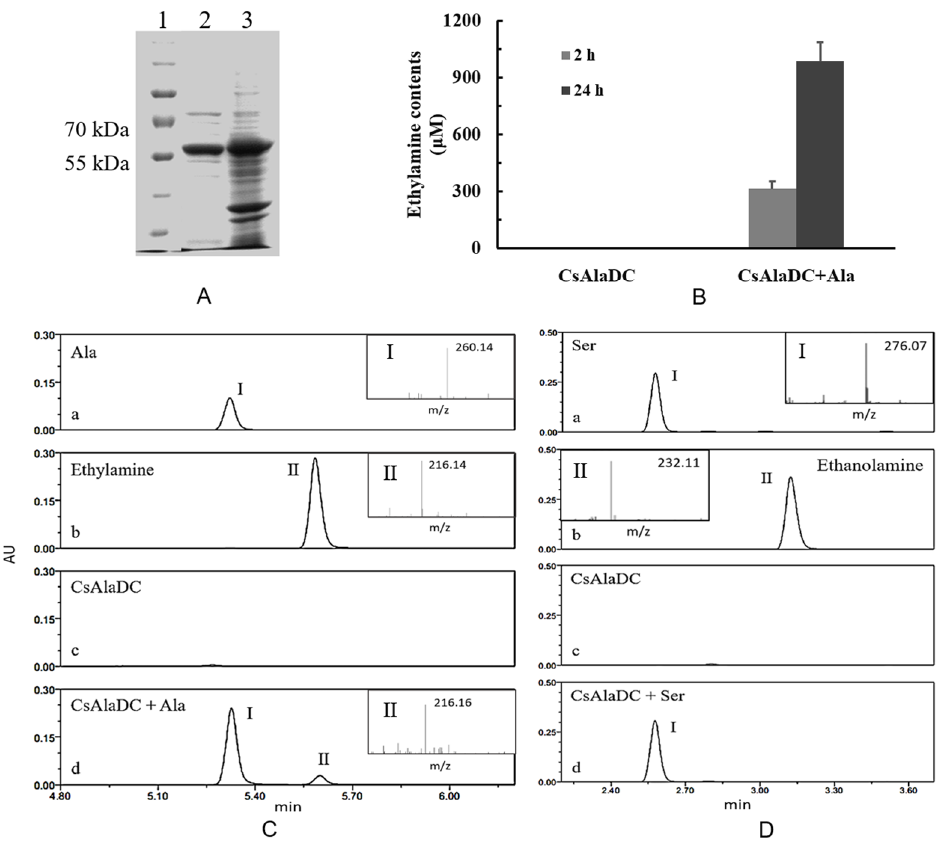
Figure 5. Expression, purification, and enzymatic activity of pCsAlaDC protein. ( A ) Gel image of pCsAlaDC protein expressed in Escherichia coli . Lanes 1–3 represent the marker, target protein, and total protein. ( B ) Measurement of AlaDC activity of the target protein. The assays were conducted by detecting the formation of ethylamine in the reaction mixture containing alanine after 2 h and 24 h of reaction at 35 °C. Error bars indicate the standard errors across three replicates. ( C , D ) Chromatogram for the decarboxylation of Ala ( C ) and Ser ( D ) catalyzed by pCsAlaDC. C-a~d (or D-a~d), the reaction buffer containing Ala (or Ser), ethylamine (or ethanolamine), pCsAlaDC, pCsAlaDC, and Ala. Peak I represents substrate Ala (or Ser), peak II represents the production ethylamine (or ethanolamine).